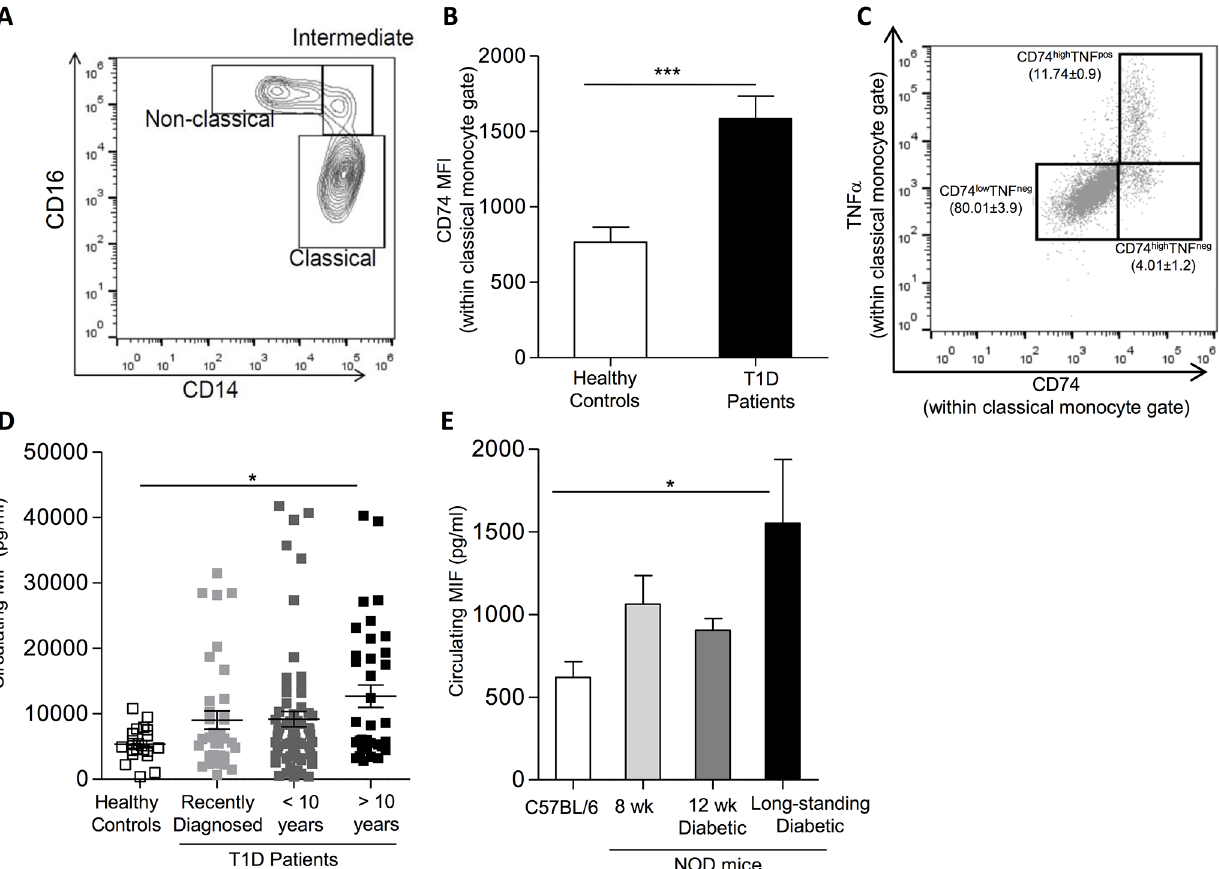
Fig 1. Circulating MIF and monocyte surface CD74expression during autoimmune diabetes. (A-C) Flow cytometric analysisof human circulating monocytes from T1D patients was performed as describedin the methods section. (A) Contourplot illustratingpart of the gating strategy employedand how the identification of the different monocyte subsets was performed. The plot illustrates the percentage of Classical-, Intermediate- and Non-classical monocytes based on their expressionof CD14 and CD16. (B) Quantificationof the mean fluorescence intensity (MFI) of surface CD74 within the classical monocyte subset. The results represent mean ± SEM (n = 10) ( *** p (cid:20) 0.005). (C) Dot plot indicating the frequency of classical monocytesproducingintracellularTNF α uponactivation. Notably, TNF α -positive cells also express high levels of surface CD74 (n = 10). (D) MIF levels detected in the plasma of healthy controls (open squares) (n = 20), recently diagnosed T1D patients (light grey squares) (n = 37) or of T1D patients with a disease duration of less than 10 years (dark grey squares) (n = 65) or more than 10 years (black squares)(n = 36). The symbols represent the individualsamples tested (mean ± SEM) ( * : p-values (cid:20) 0.05). (E) CirculatingMIF levels as detected by ELISA in control C57BL/6mice (white bar) (n = 6), pre-diabetic NOD mice (8 weeks) (light grey bar) (n = 10), or diabeticNOD mice (12 weeks) (dark grey bar) (n = 8) or long-standing diabetic NOD mice (16 weeks and older) (black bar) (n = 4). Results show the mean ± SEM ( * : p-values (cid:20) 0.05).